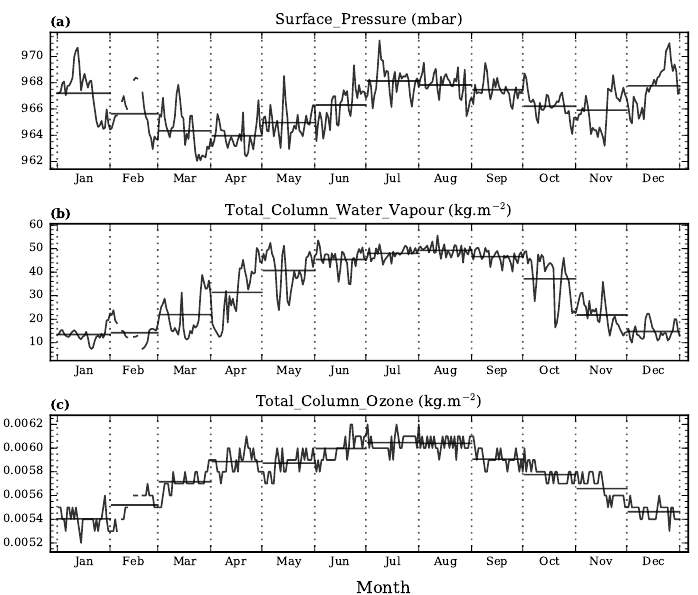
Figure 3. ( a ) Surface pressure, ( b ) total column water vapor, and ( c ) total column ozone variations in Maroua in 2014, extracted from European Center for Medium-Range Weather Forecasts (ECMWF) databases. Horizontal segments represent monthly averages and vertical dashed lines represent month